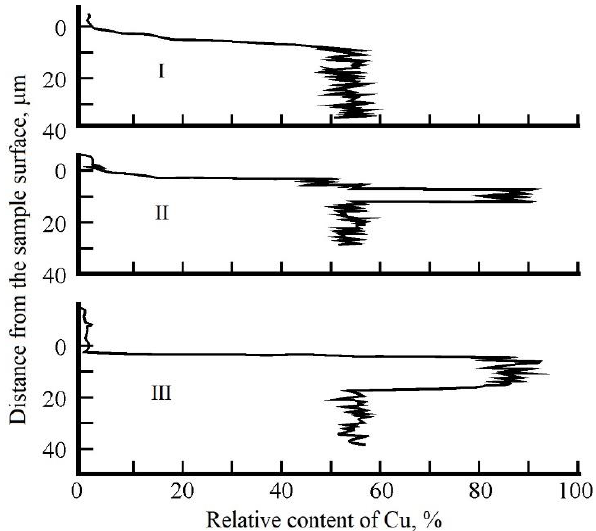
Figure 11. Results of studies of the chemical composition of the near-surface layer of samples regions: I—not exposed to laser irradiation; II—in the peripheral region; III—in the central region of the heat-affected zone after laser treatment.